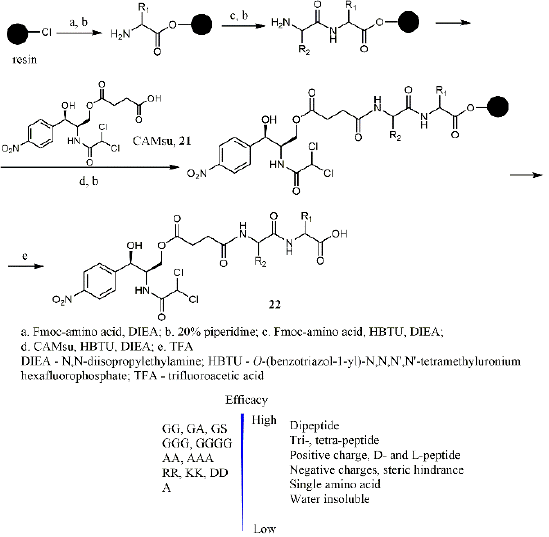
Table 2. Antibacterial activity of peptide-CAM conjugates 22 against E. coli K-12 (MIC, µ